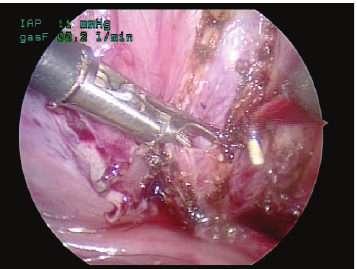
Figure 5: Dissection of the submucosal tunnel.